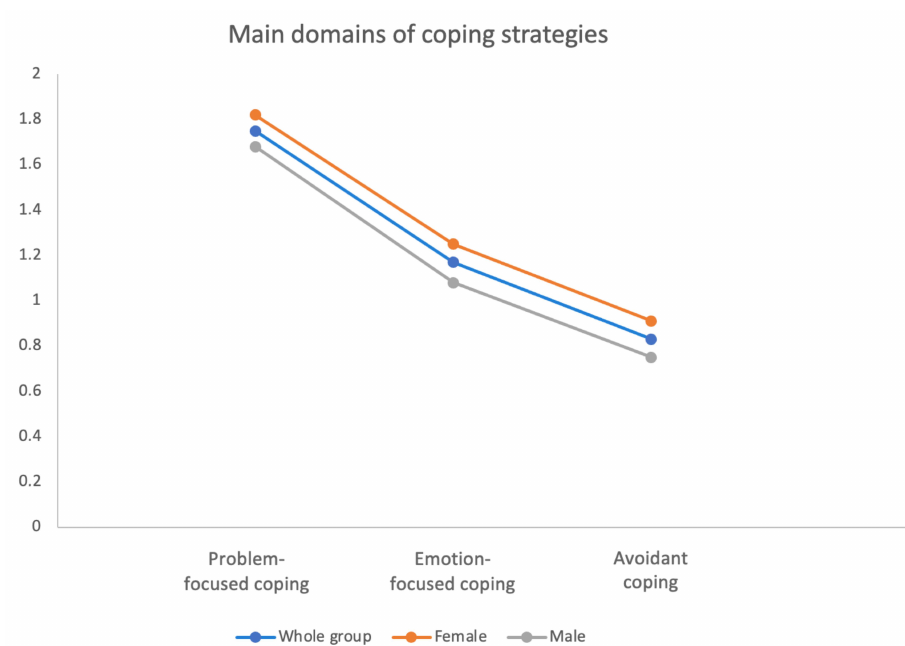
Figure 2. Frequency of utilizing of main domains of coping strategies.